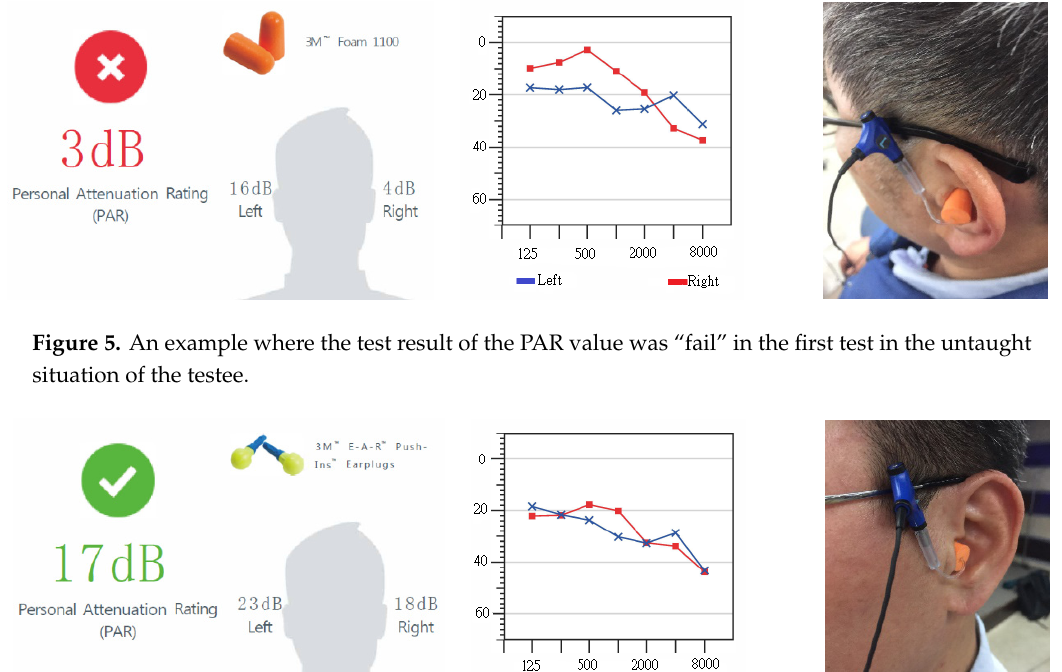
Figure 3. The flowchart of the evaluation process for the 3M™ EA-RfitTM HPD adaptability evaluation system applied in this study.